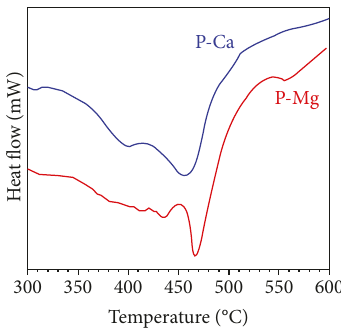
Figure 6: Thermal analysis of pectin-Mg 2+ and pectin-Ca 2+